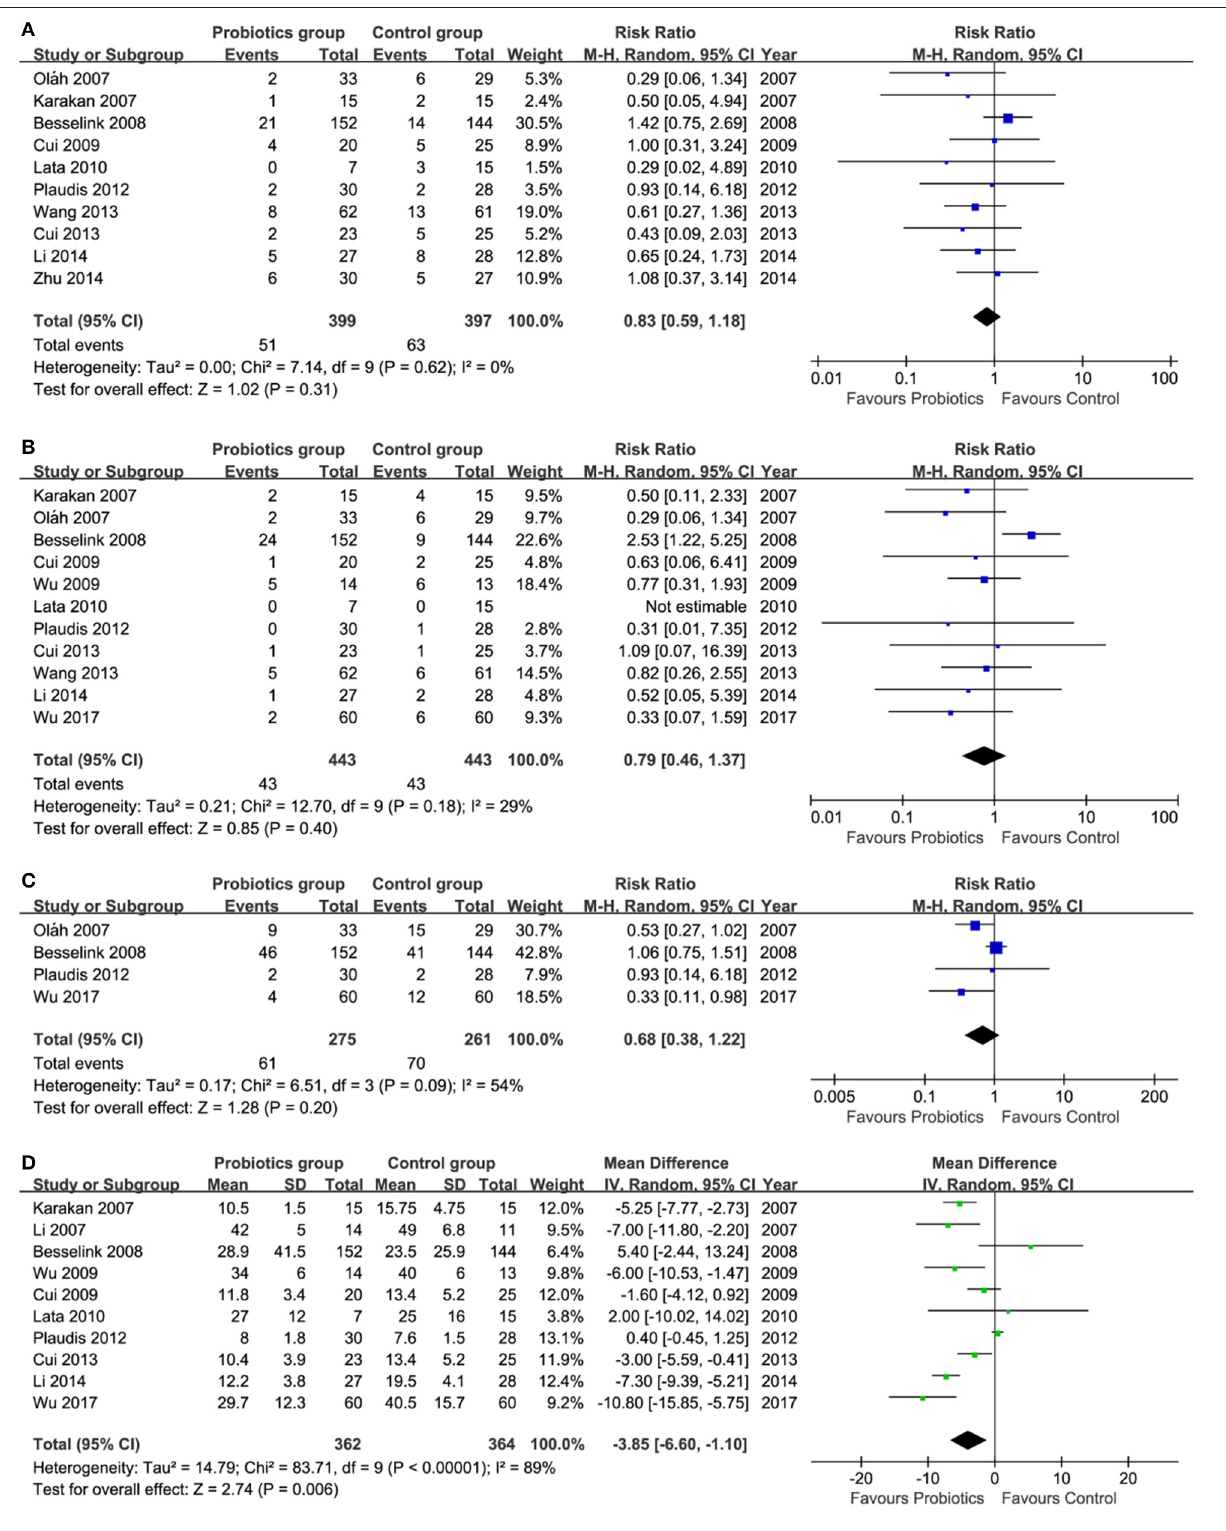
Frontiers in Pharmacology |